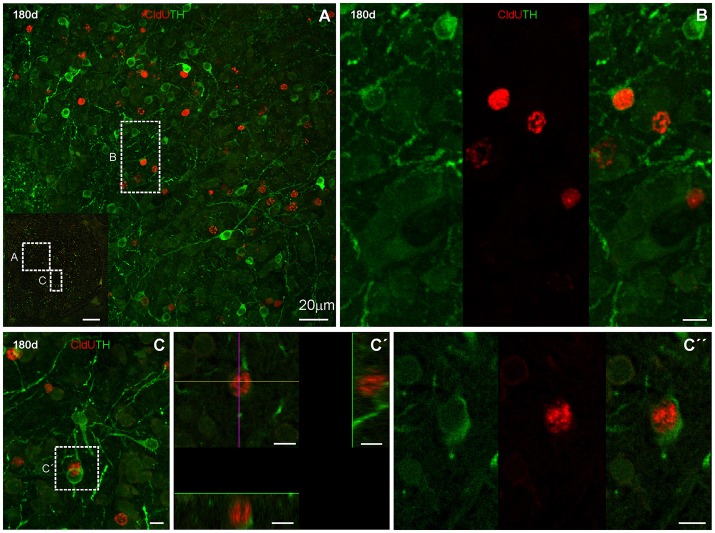
Neuronal differentiation in the rostral olfactory bulb at 180 days after four daily injections of CldU demonstrated by co-localization with TH. Microphotograph at the region of the rostral OB indicated by the rectangle in the inset in (A). (B) Higher power images of both channels and the overlay of the region containing a cell of interest at the region indicated by the dotted square in the inset in (A). (C) Maximal intensity projection of a stack of 17 confocal planes, every 0.5 μm. The rectangle indicates the location of a cell which co-localization was demonstrated by x-z and y-z orthogonal projections of the same stack (C′) as well as each channel and overlay of the sequentially acquired channels a single plane (C′′). Scale bars: (A) 20 μm; (B, Inset in A) 100 μm; (B,C′′) 5 μm.